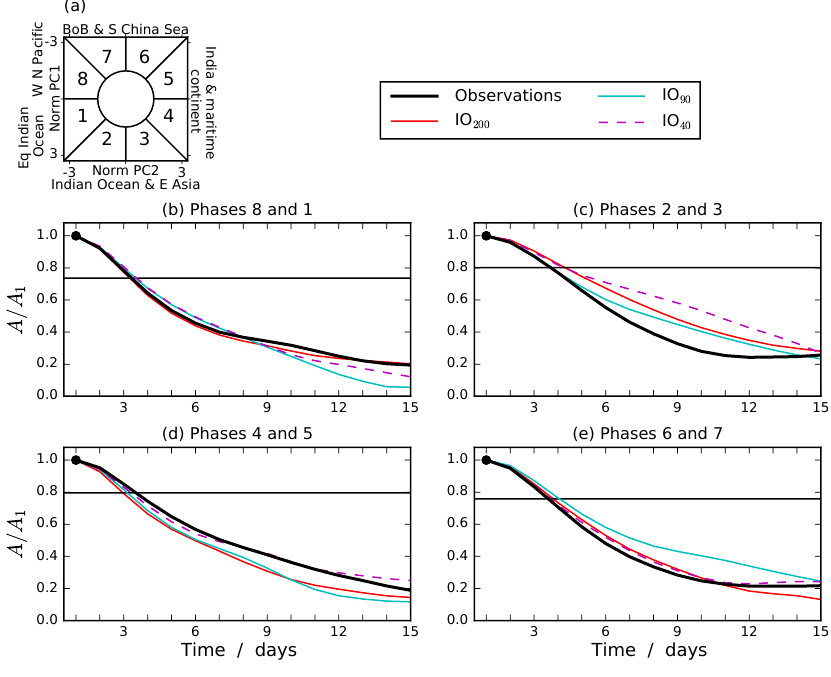
Figure 15. As Fig. 12 but for IO 200 , IO 90 , and IO 40 . Table 3. List of further experiments referred to in Sect. 4. See Table 1 for full explanation. Experiment UM grid